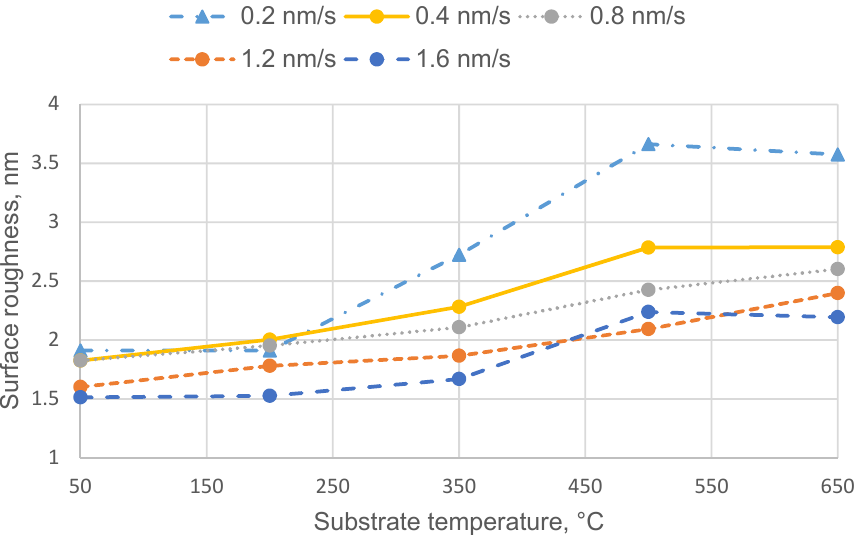
Figure 7. Plots of surface roughness versus substrate temperature obtained by using different growth rates.